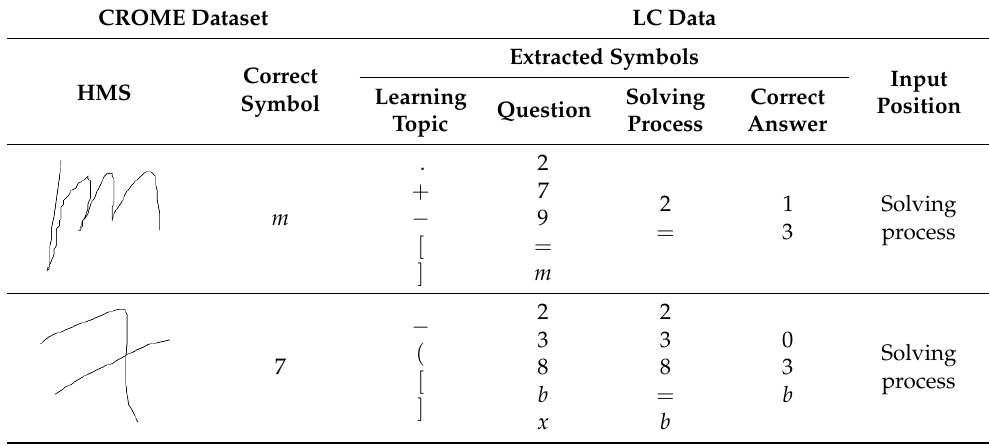
Table 8. Configuration of LC information recognition based artificial neural network. No. Layer Setting